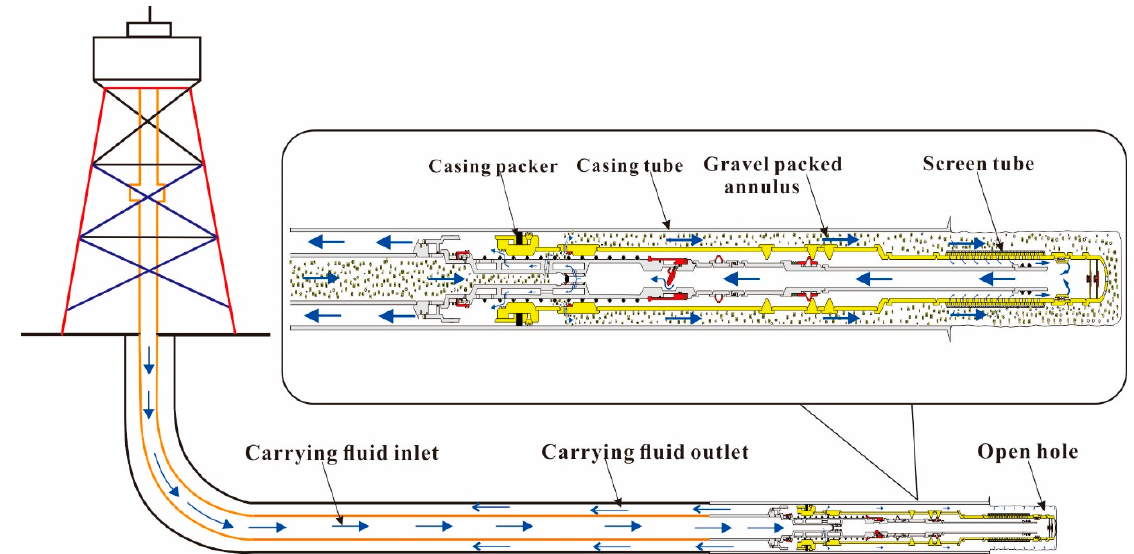
Figure 1. Schematic diagram of pulsed gravel packing in horizontal wells.